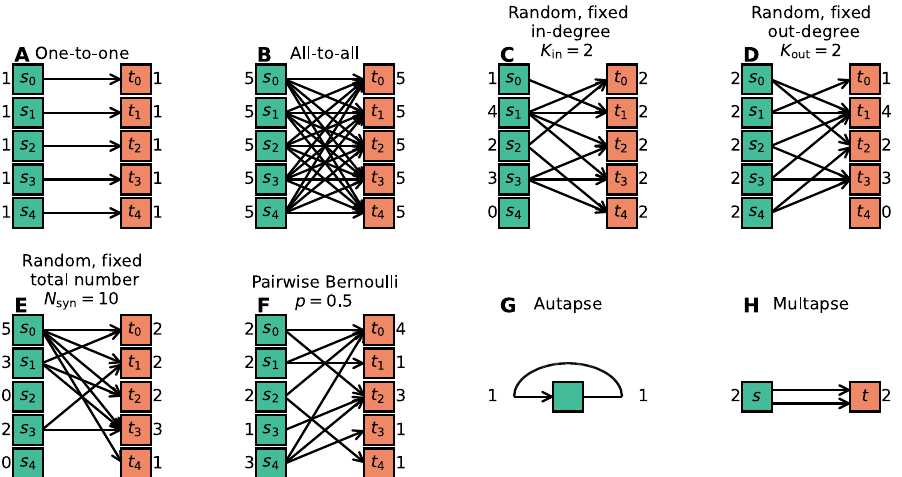
Fig 7. Connectivity patterns reflecting the most common rules. The ordered set of sources S is depicted by the green squares on the left. They are connected to the ordered set of targets T , depicted by the orange squares on the right. The respective in- and out-degrees are given next to the nodes. (A) One-to-one. (B) All-to-all. (C) Random, fixed in-degree with K in connections per target node. (D) Random, fixed out-degree with K out connections per source node. (E) Random, fixed total number of connections N syn . (F) Pairwise Bernoulli with connection probability p . (G) Autapse (self-connection). (H) Multapse